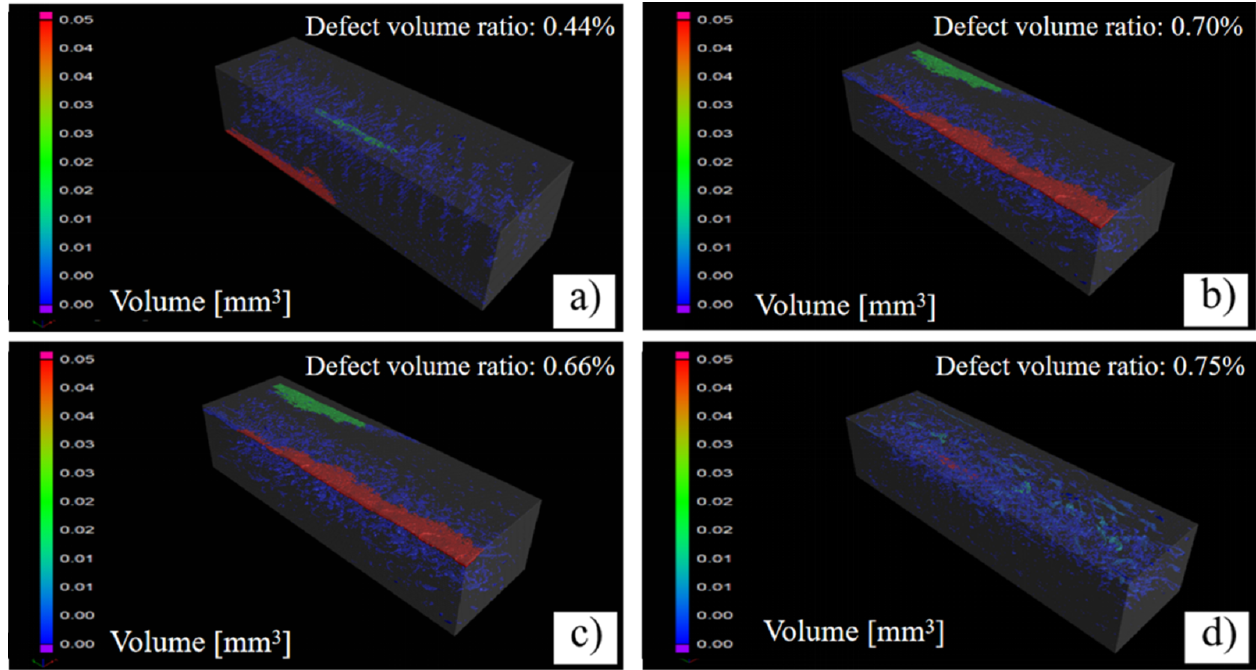
Figure 10. Micro-CT scans of the gauge section of tensile specimens with different raster